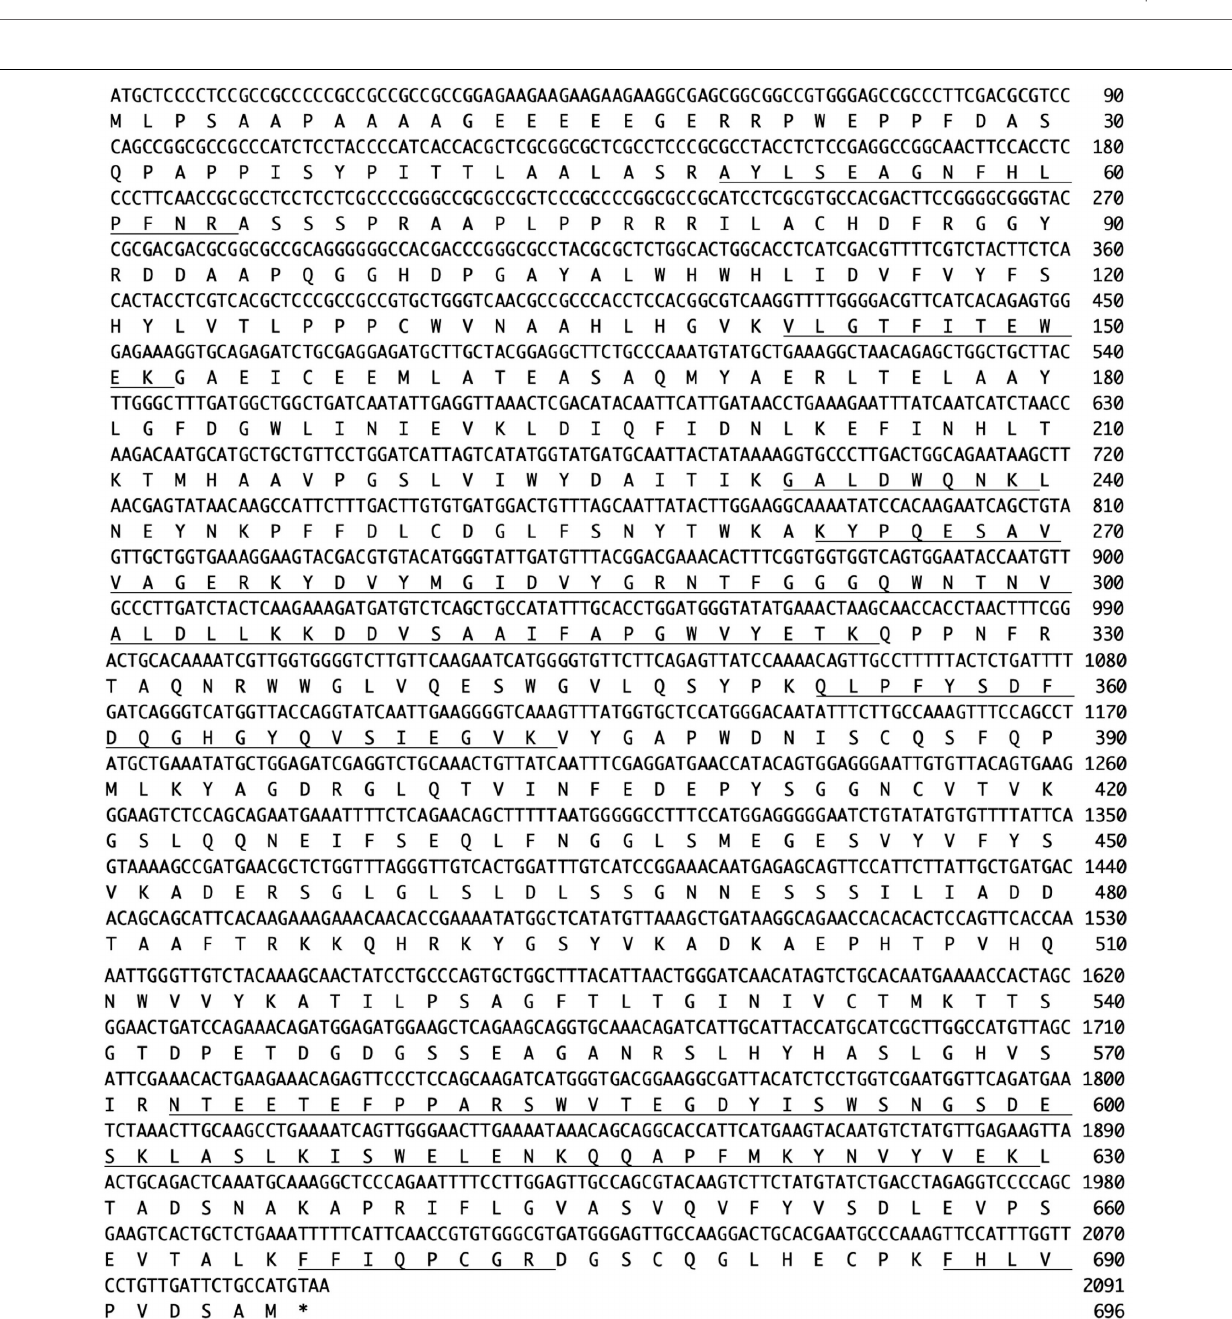
FIGURE 3 | Nucleotide sequence ( Os05g0346500 ) and amino acid sequence (UniProt ID: Q5W6R1) of Endo-Os. Underlining indicates identified peptide sequences.